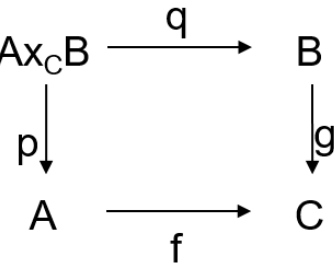
Figure 4. Structure of the